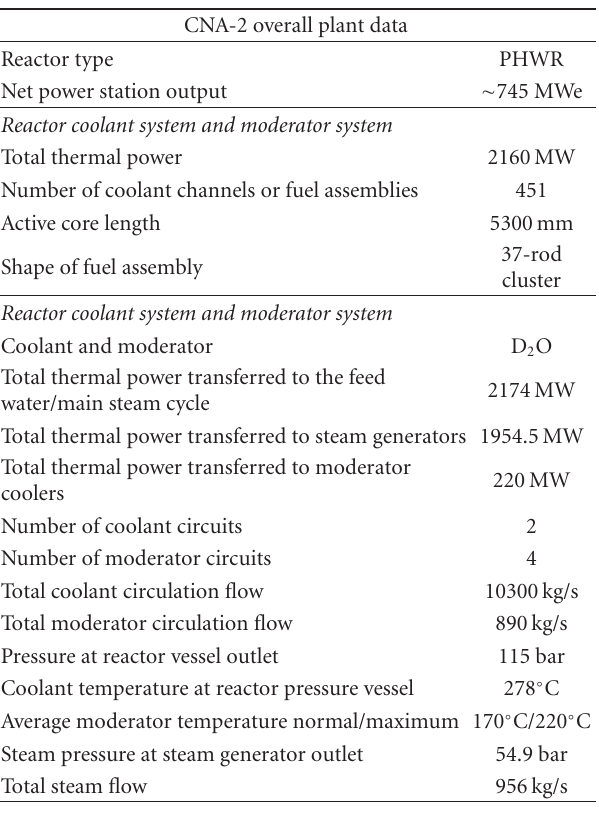
Table 1: CNA-2 PHWR NPP overall